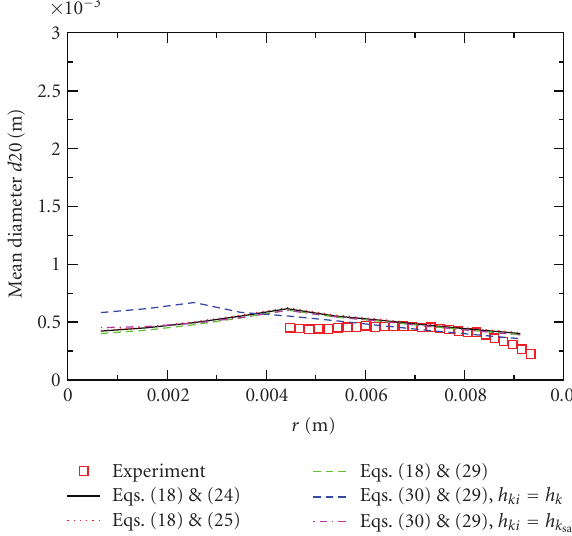
Figure 4: comparison of the di ff erent models on the interfacial area profile.